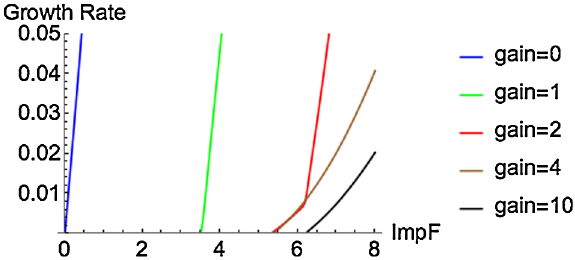
FIG. 19. Same as Fig. 15, but for the resistive damper. Note the fjord of stability.